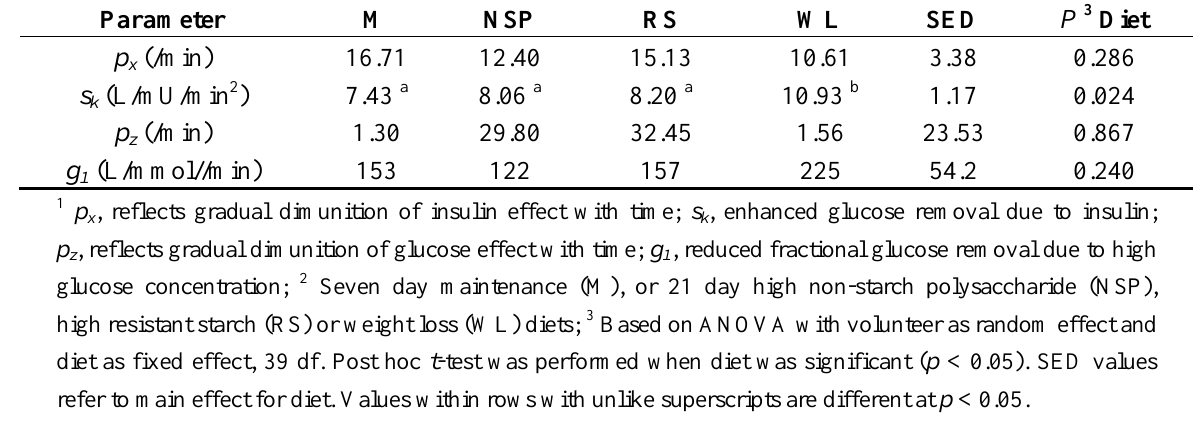
Table 5. Estimated parameters 1 for the Formal model following the dietary interventions 2 .